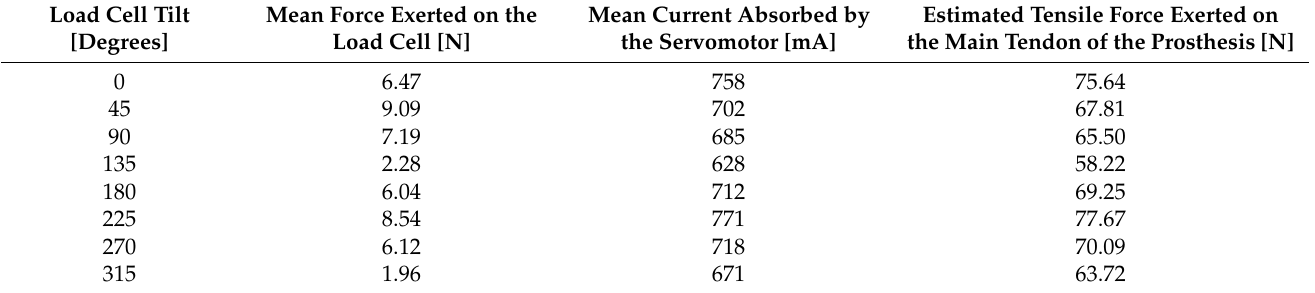
Figure 14. Example of experimental data recorded during the power grip test (here handlebar tilted 45 degrees): ( A ) Absorbed current by the servomotor; ( B ) Grip force on the handlebar (load cell output). Table 1. Experimental data of the grip tests. For each angular position of the handlebar: the mean value of force exerted on the load cell in the handlebar, the mean value of current absorbed by the servomotor and the estimated force exerted on the main tendon of prosthesis.